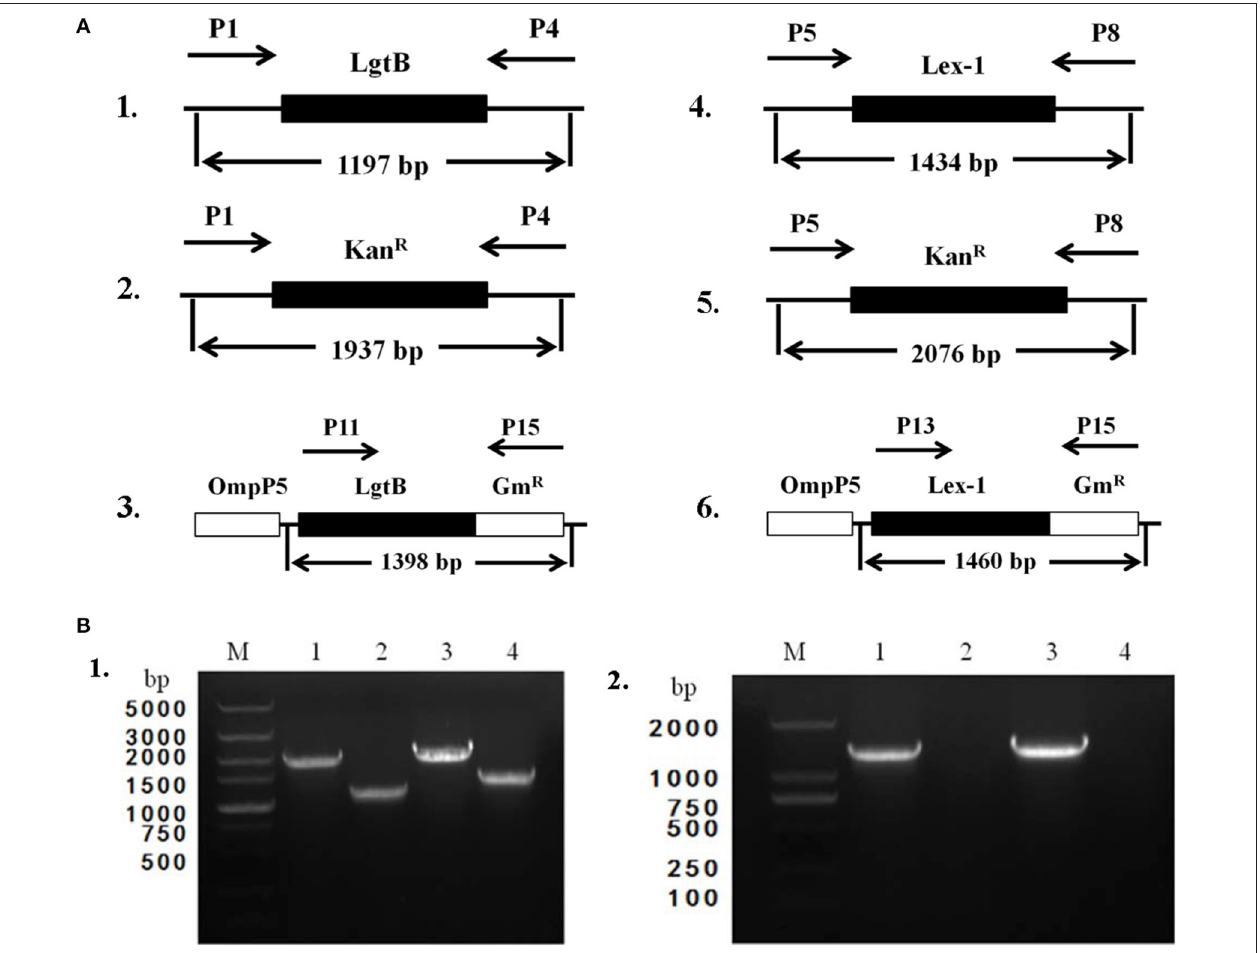
FIGURE 2 | Construction and characterization of 1 lgtB and 1 lex-1 mutants and complemented strains. (A) Parts 1–3 show the maps of the lgtB gene of wild-type SC096, the lgtB ::Kan R insertion mutant and its complemented strain. Parts 4–6 show the maps of the lex-1 gene of wild-type SC096, the lex-1 ::Kan R insertion mutant and its complemented strain. (B) Part 1, Primers P1 and P4 were used to amplify upstream to downstream of lgtB from the 1 lgtB mutant strain (lane 1), the wild type SC096 (lane 2); Primers P5 and P8 were used to amplify upstream to downstream of lex-1 from the 1 lex-1 mutant strain (lane 3), the wild type SC096 (lane 4). Part 2, Primers P11 and P15 were used to amplify lgtB and Gm R from the 1 lgtB -c strain (lane 1), the wild type SC096 (lane 2); Primers P13 and P15 were used to amplify lex-1 and Gm R from the 1 lex-1 -c strain (lane 3), the wild type SC096 (lane 4).